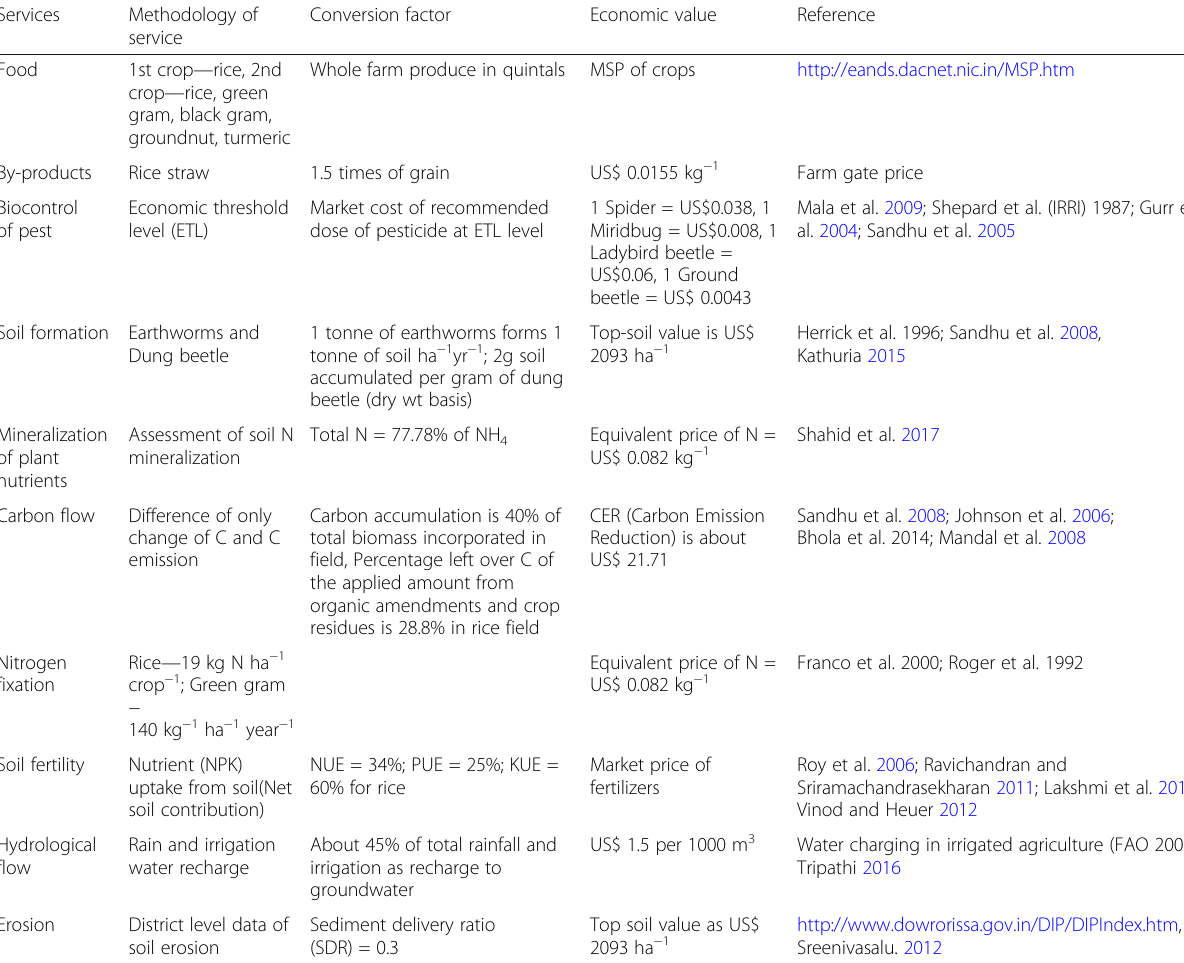
Table 2 Reference table of rice eco-system services Services